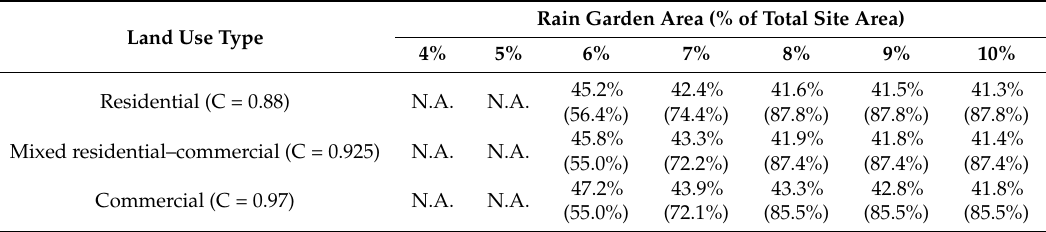
Table A11. Required treated catchment areas and rain garden sizes to achieve C = 0.55 for the various land use types (percentages in brackets represents the upper limits beyond which the C-value would exceed 0.55 due to deteriorating performance of the rain